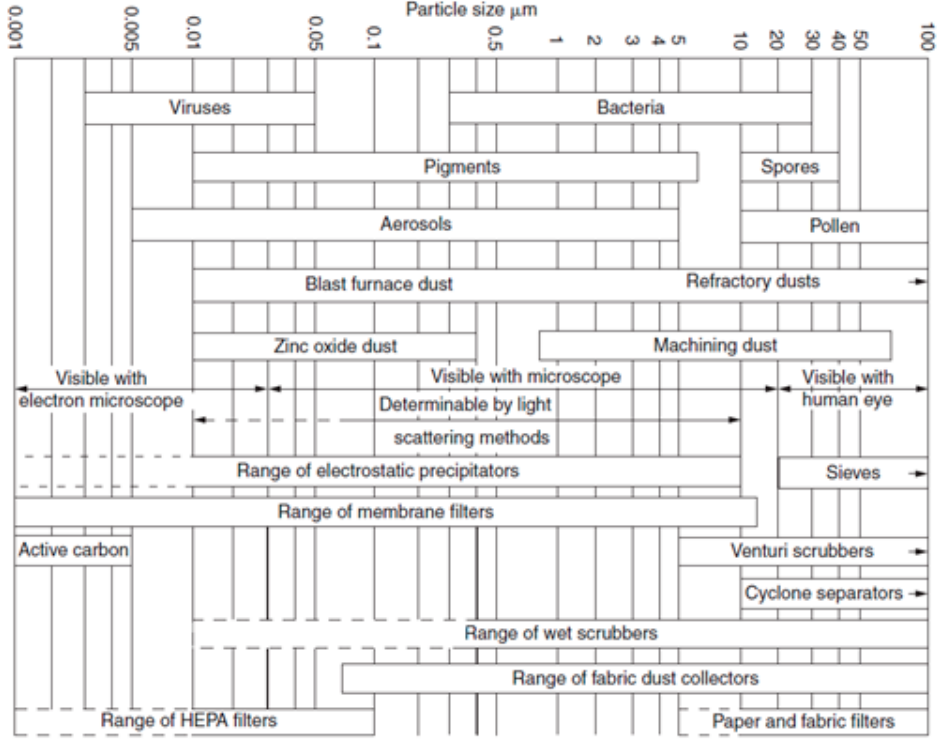
Figure 1. Comparison of types of separators for trapping aerosol particles [19].